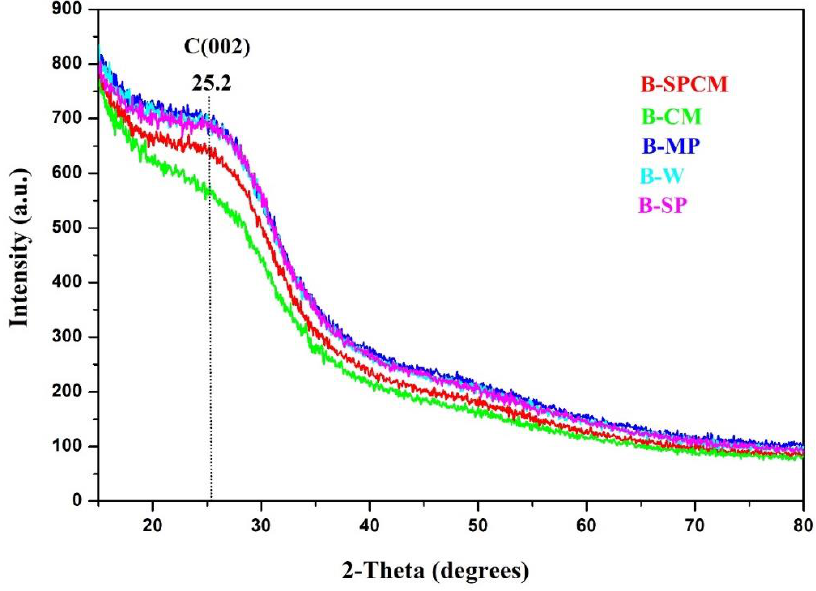
Figure 5. XRD Patterns of B-SPCM, B-CM, B-MP, B-W, and B-SP.